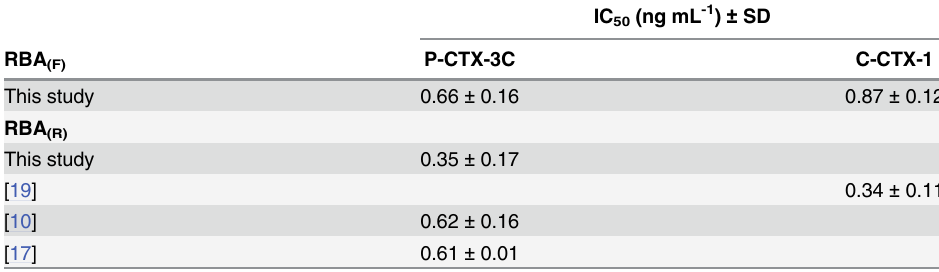
Table 1. RBA (F) and RBA (R) IC 50 Values. Literature and this study ’ s IC 50 values of ciguatoxins P-CTX-3C and C-CTX-1 for fluorescent and radiolabeled receptor binding assays (RBA (F) and RBA (R) ). Error is repre- sented as ± standard deviations (SD).